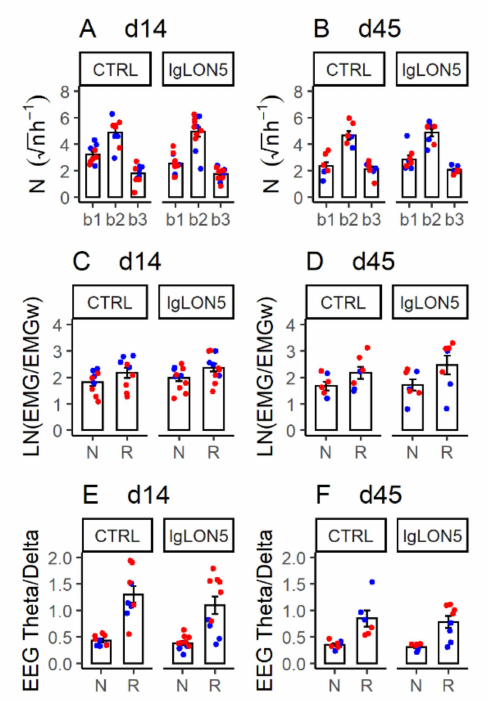
Figure 5. Indexes of sleep architecture ( A , B ) and quality ( C , F ) in female wild-type (blue) and hTau (red) mice with intracerebroventricular infusion of antibodies from a patient with anti-IgLON5 disease (IgLON5) or from a control (CTRL) subject. ( A , B ): square-root transformed numbers of episodes of NREM sleep with duration 4–8 s (b1), 12–120 s (b2) or >120 s (b3) per hour recording time during the first 8 h of the light period. ( C , D ): log-transformed ratios of electromyogram (EMG) root mean square during sleep (N: NREM sleep; R: REM sleep) and during wakefulness (EMGw). ( E , F ): ratios of electroencephalogram (EEG) theta and delta power during N and R. ( A , C , E ): data obtained at the end of the 14-day infusion (d14). ( B , D , F ): results obtained ≥ 1 month afterward (d45). Bars show means ± SEM. Dots show values in individual mice. Detailed statistical results are reported in Tables